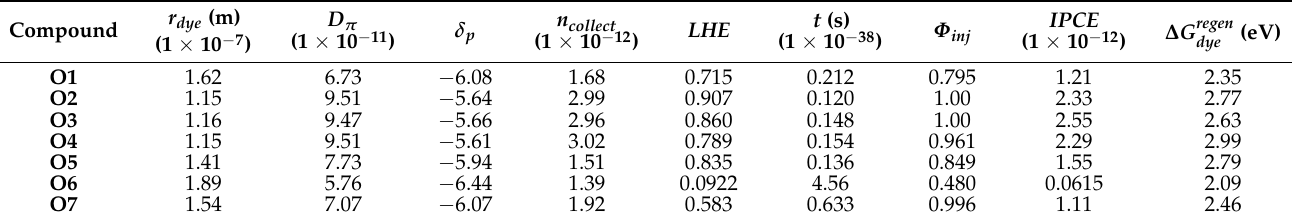
Table 3. Photovoltaic parameters of compounds that were tested as organic